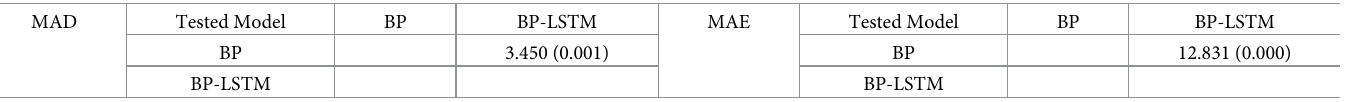
Table 4. Comparison of Diebold-Mariano test values of models under different error measurement methods. MAD Tested Model